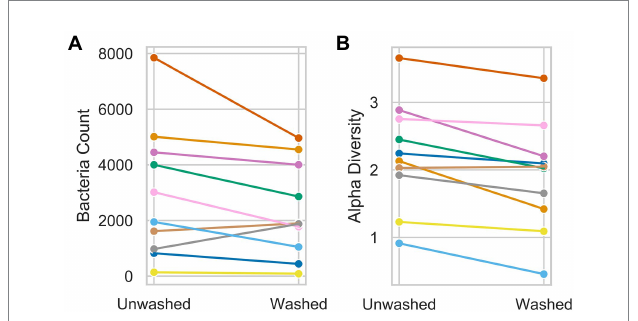
FIGURE 1 Illustration of the difference before and after washing for total bacteria counts of axillary samples of the cultural data (A) and the Shannon alpha diversity of neck samples of the ASV data (B) . Each dot represents the bacteria count (A) or the alpha diversity (B) of one